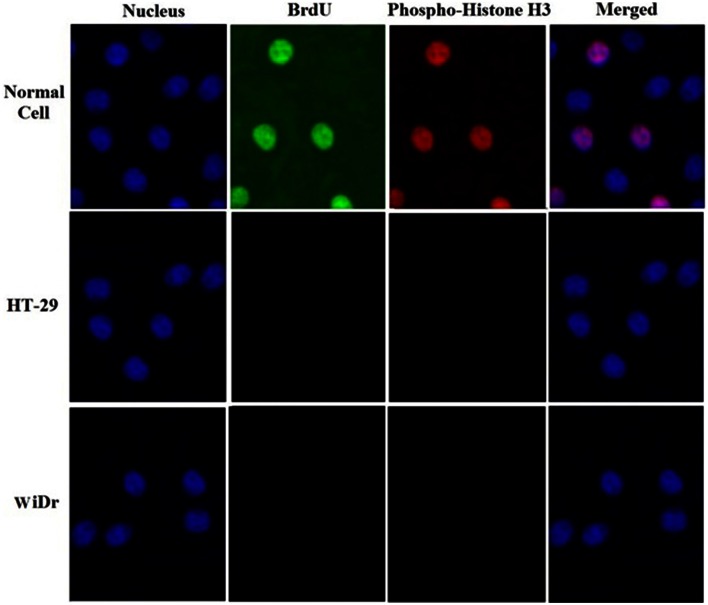
NTC arrests the cell cycle in the S/M phase. Cells were incubated with DMSO (control negative) and NTC (6.0 μM) for 24 h following collection and staining with BrdU and Phopho-Histone H3. Treatment with NTC revealed no significant changes in the BrdU and Phosho-Histone H3 fluorescence intensity which suggests that the cells have not been arrested at S/M phase.